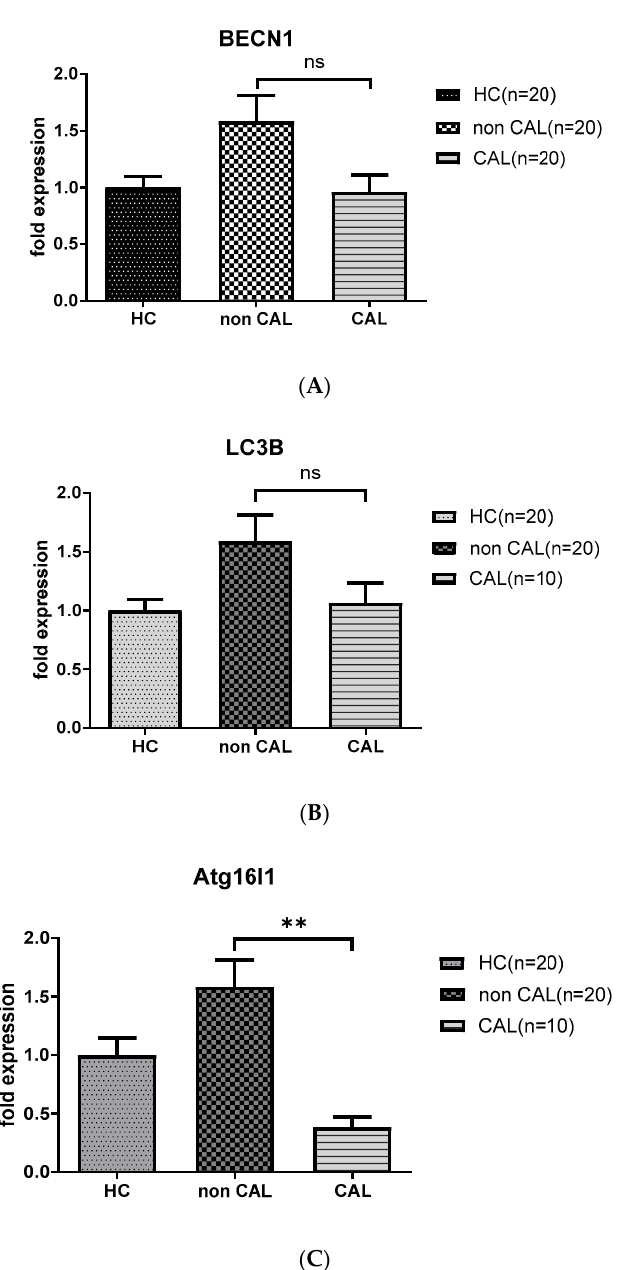
Figure 2. Analyses of mRNA autophagy markers in the peripheral white blood cells of Kawasaki disease (KD) patients without and with coronary artery lesions. Total RNA from the peripheral white blood cells of healthy controls (HC, n = 20) and KD patients without (non CAL, n = 20) and with coronary artery lesions (CAL, n = 10) 21 days after (KD3) IVIG treatment was isolated using a total RNA purification kit. Reverse transcription was performed using a high-performance reverse transcriptase system, as described in the Methods section. The levels of BECN 1 ( A ), LC3B ( B ) and ATG16L1 ( C ) mRNA was measured by a real-time quantitative polymerase chain reaction (RT-qPCR). The expression levels were normalized to those of GAPDH . The comparisons between the two groups of KD patients were analyzed. Data are expressed as mean ± standard error. ** p < 0.01 (by Mann–Whitney U test).